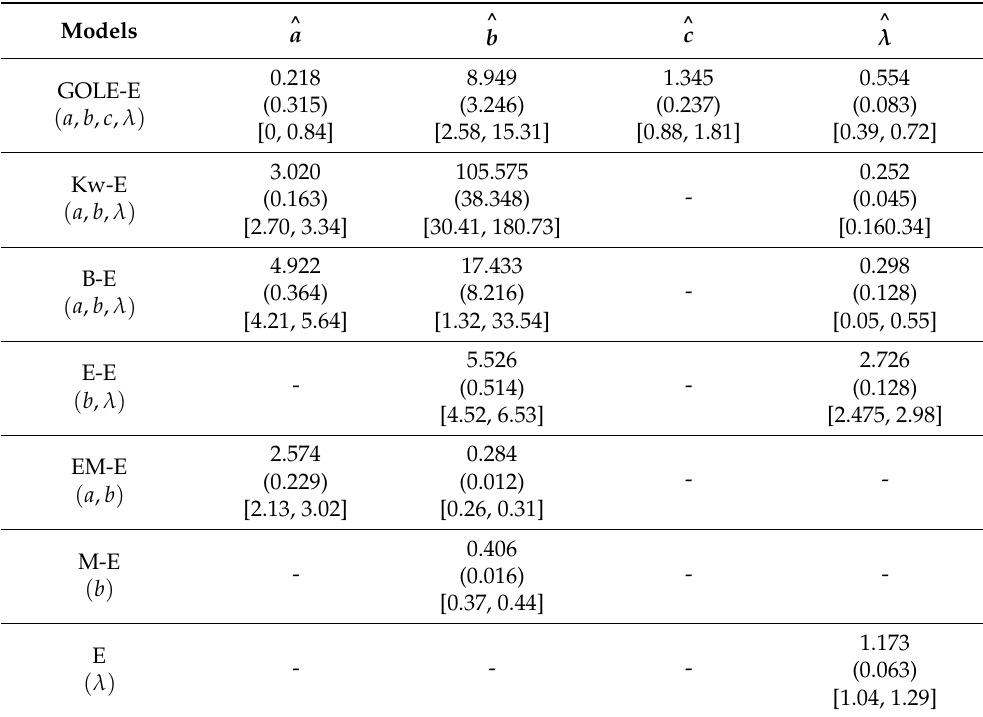
Table 3. MLEs, standard error (in parentheses), confidence interval values [in brackets] for the data set I.